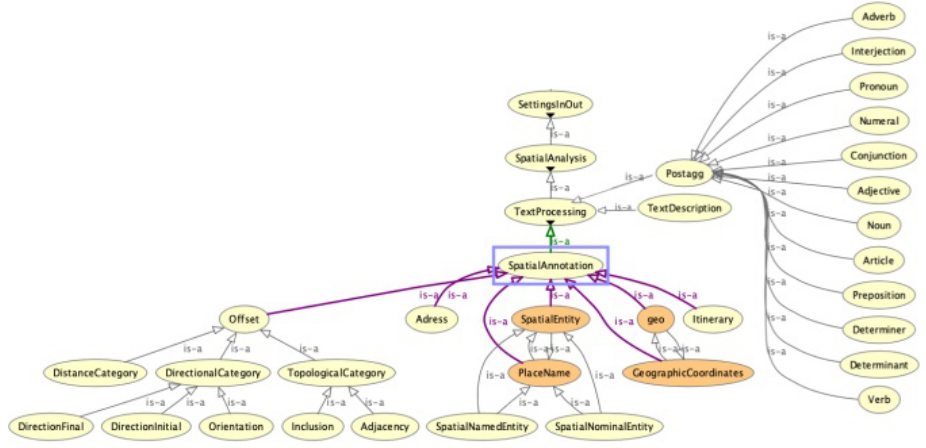
Figure 9. Extract from the data ontology for the R2 request